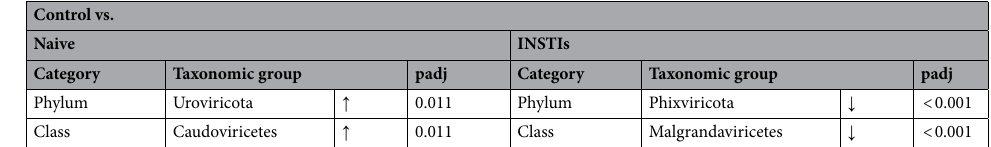
Table 1. Phage taxonomical ranks which present a differential abundance in the studied population. INSTIs integrase strand transfer inhibitors-based treatment.